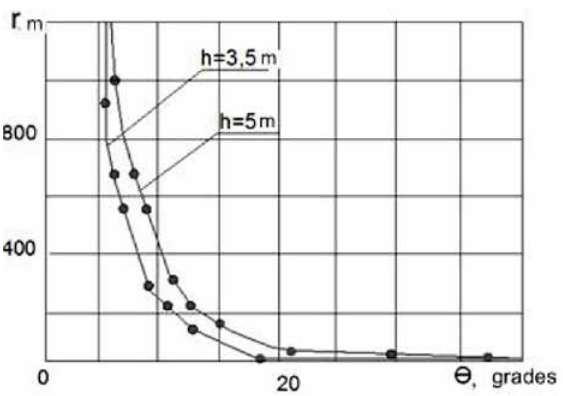
Fig. 2. Dependence of a radius on the final angle of a